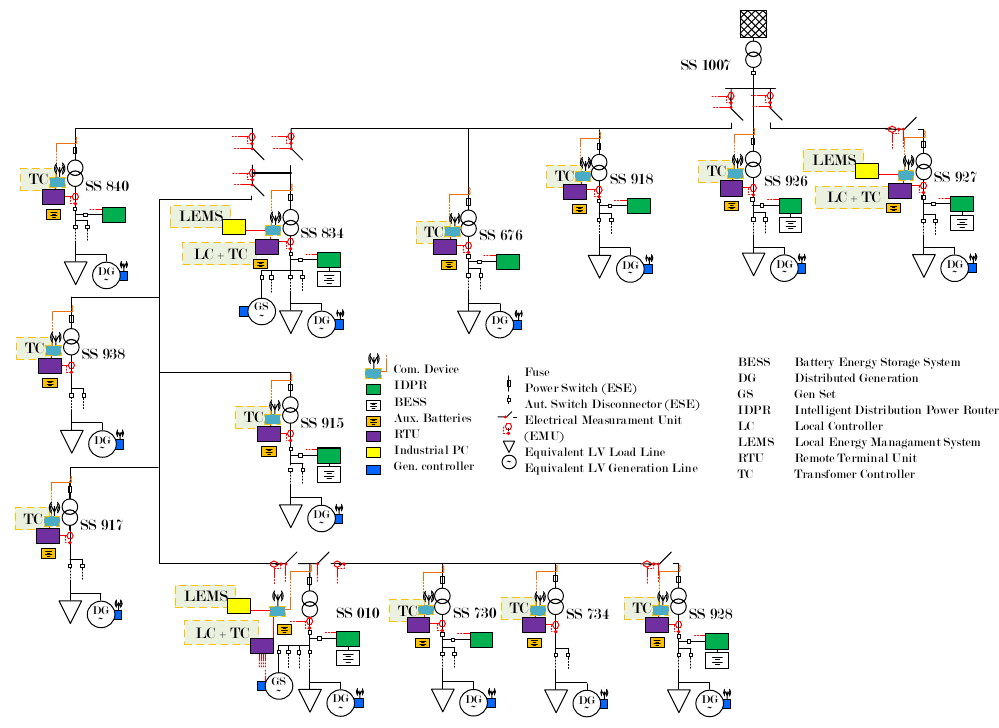
Figure 3. The whole rural distribution grid.